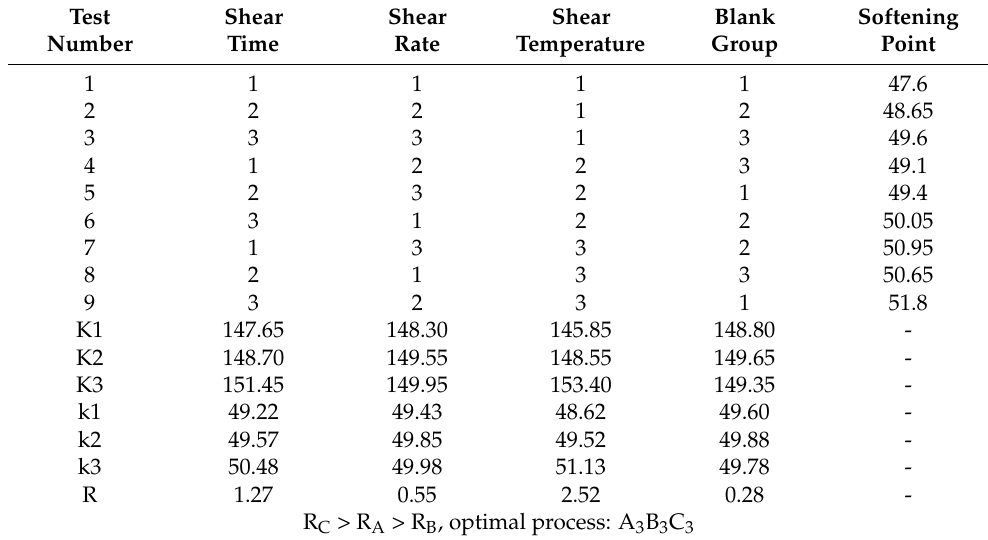
Table 6. Softening point range analysis results.